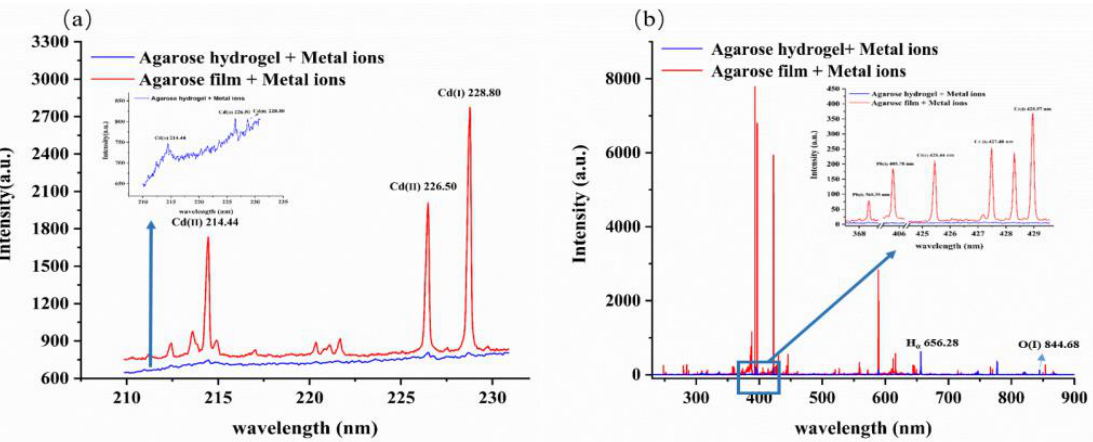
Figure 1. The LIBS spectra of agarose hydrogel and agarose film samples prepared by 2 mg L −1 metal ion solution collected by spectrometer SR-500i-A-R ( a ) and spectrometer ME5000 ( b ).